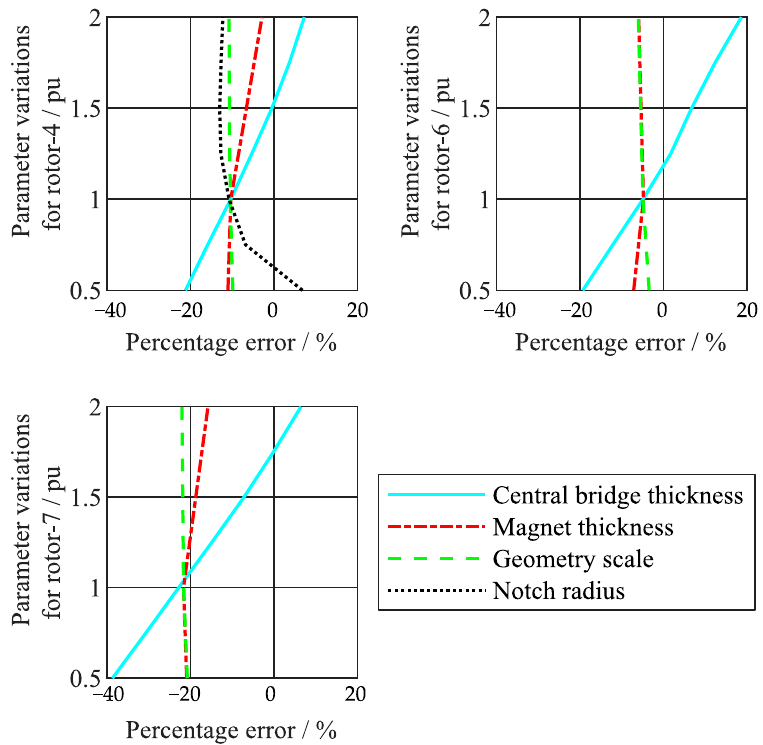
Figure 12. Stability analysis of the CBM method for parameter variations of various rotor geome- tries.